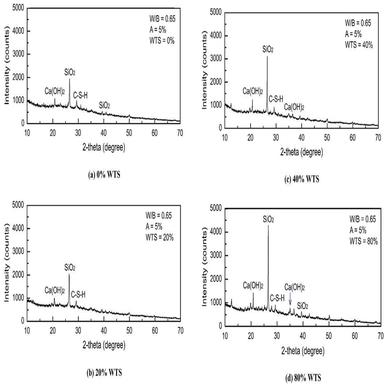
XRD pattern results for the CLSM mixtures with 0.65 w/b, A of 5%, and varying WTS content levels.